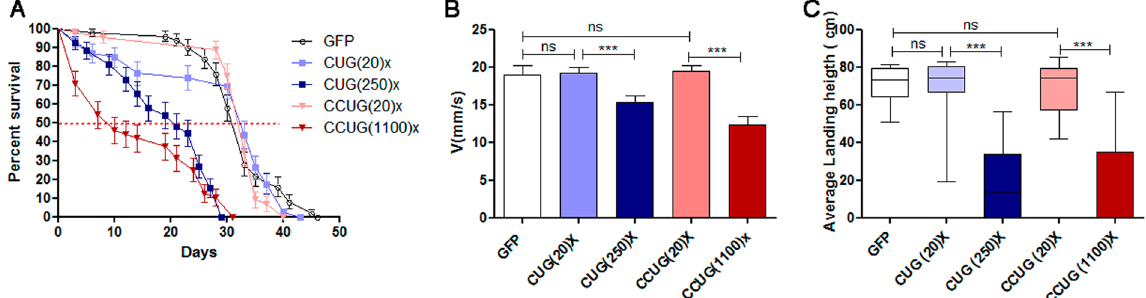
Figure 5. Survival and locomotor function were reduced in flies expressing expanded CUG or CCUG repeats in muscle. ( A ) Average percentage of live flies versus age (in days). The Mhc-Gal4 driver was used to induce the expression of the indicated constructs in muscle. The horizontal dotted line marks the median survival. Whereas control and short-repeat-expressing flies had similar median survival (GFP; n = 90, CUG(20) × , n = 100 and CCUG(20) × , n = 95), long CUG and CCUG-expressing flies have reduced survival (CUG(250) × ; n = 95 and CCUG(1100) × ; n = 100). Differences in the survival curves were highly significant (p < 0.0001, log- rank test). ( B ) Histogram showing the climbing speed as the mean speed ± SEM in mm/s. Flies expressing long CUG or CCUG repeats had reduced climbing velocity compared to control flies or flies expressing the short versions of repeats. ( C ) Notched box plot showing the median and the distribution of the average landing